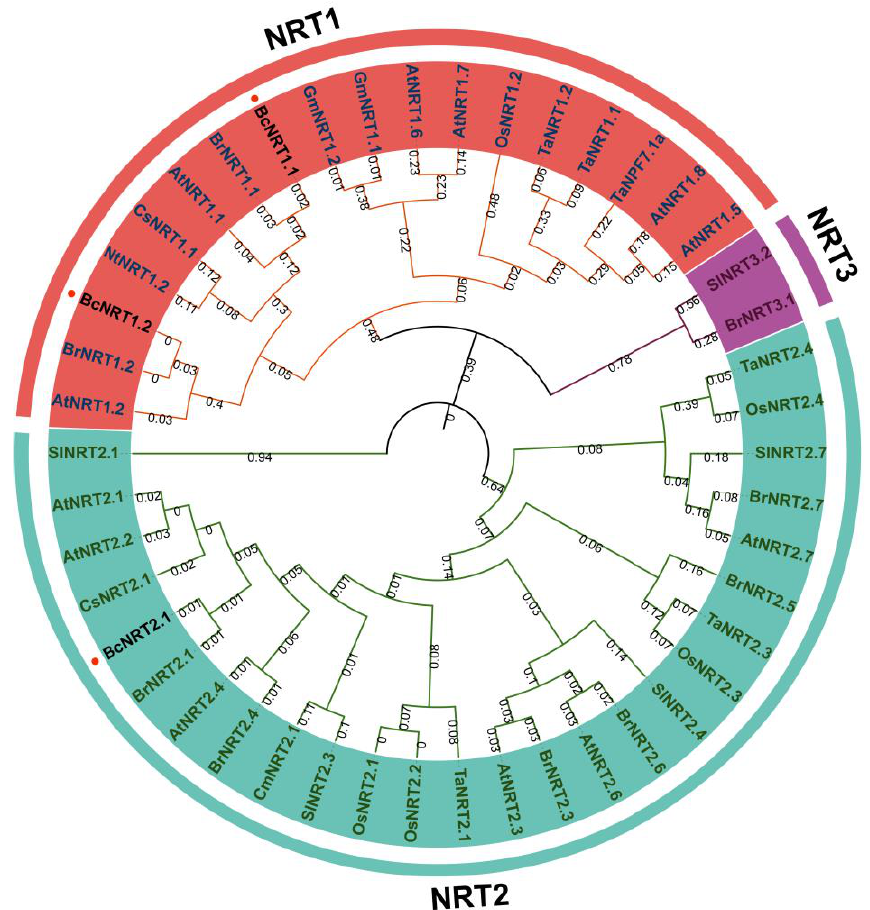
Figure 1. Phylogeny tree of NRTs from different species. At: Arabidopsis thaliana , Bc: Brassica campestris , Sl: Solanum lycopersicum , Ta: Triticum aestivum , Os: Oryza sativa , Nt: Nicotiana tabacum , Gm: Glycine max , Cs: Camelina sativa , Br: Brassica rapa , Cm: Chrysanthemum × morifolium. The numbers on the branches represent evolutionary distances. The sequence information for each protein is provided in Table S2.